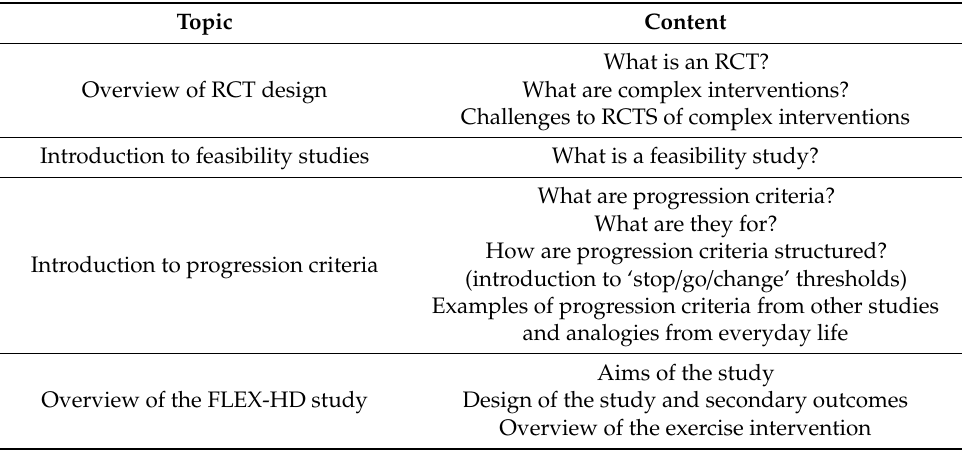
Table 1. Outline of education session content for the initial discussion groups. RCT: randomised controlled